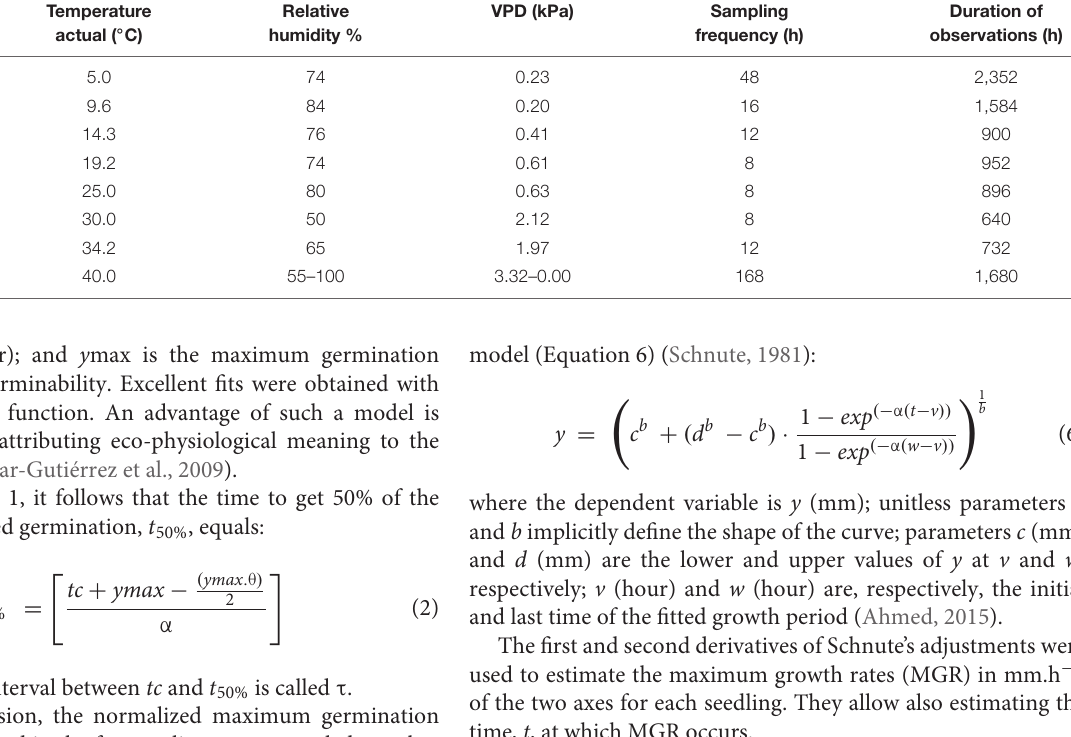
TABLE 2 | Temperatures, relative humidity, and vapor pressure deficit (VPD) were measured for germination. Temperature treatment ( ◦